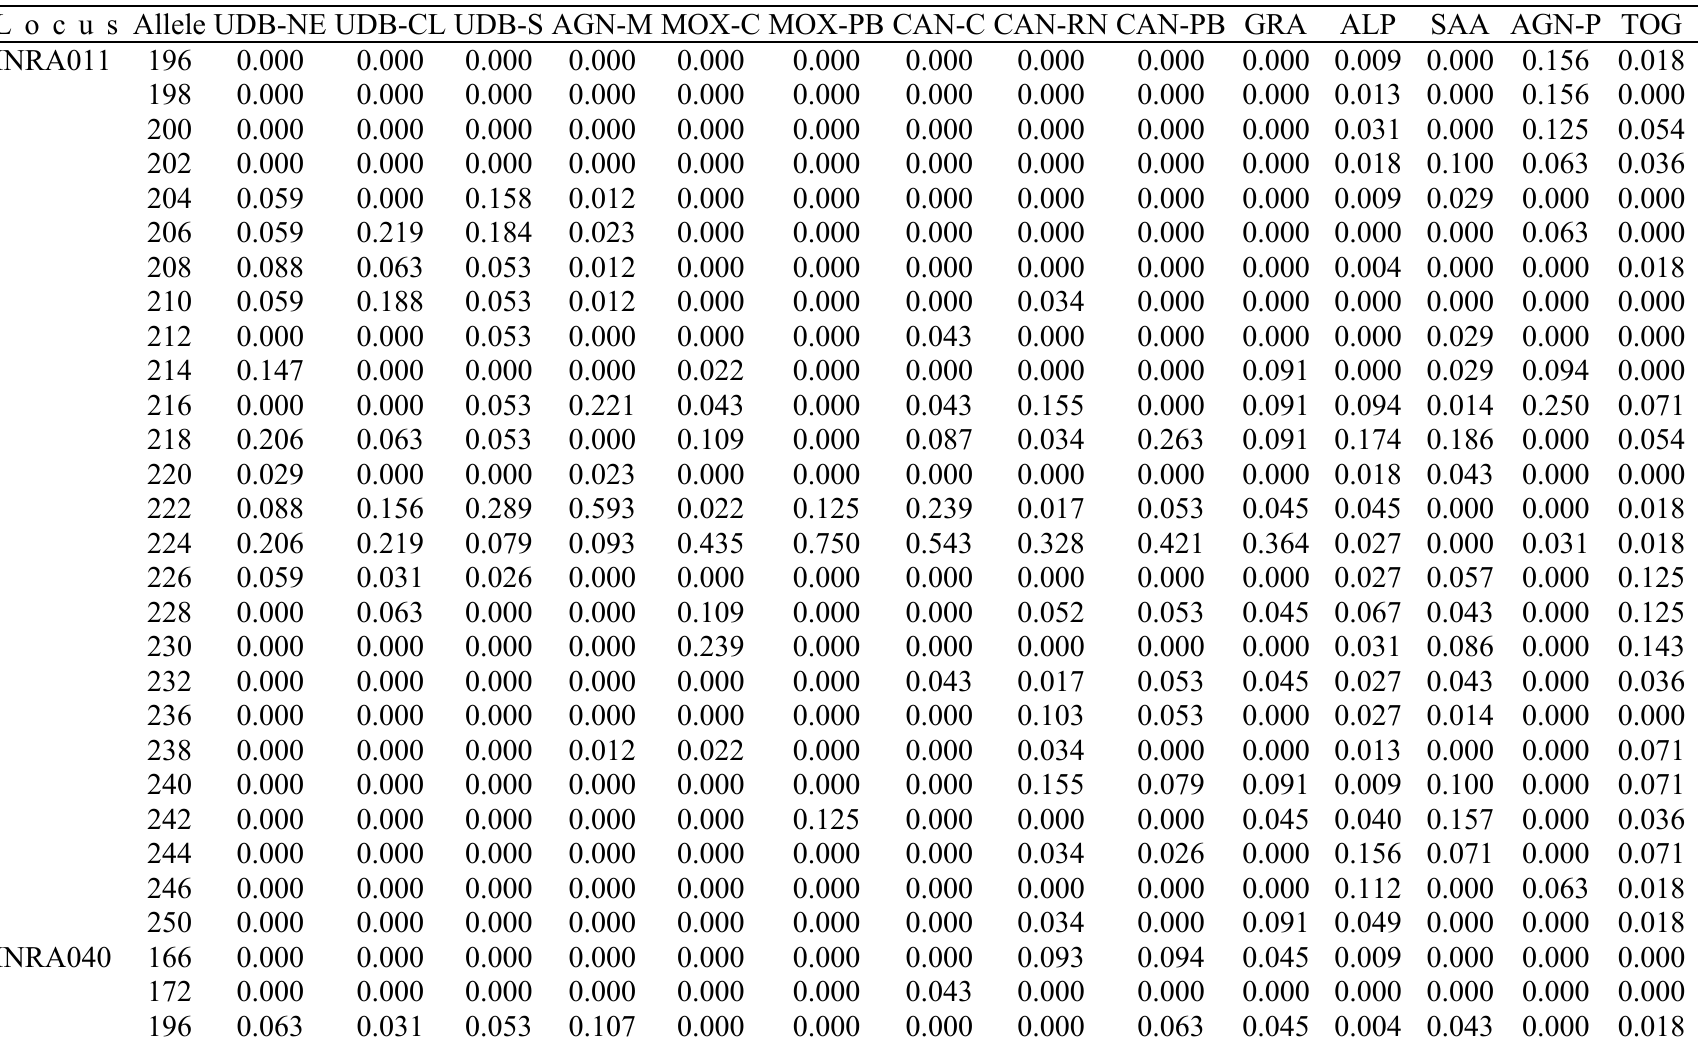
Table S1 – Allele Frequencies for the Polymorphic Loci for Each Goat population